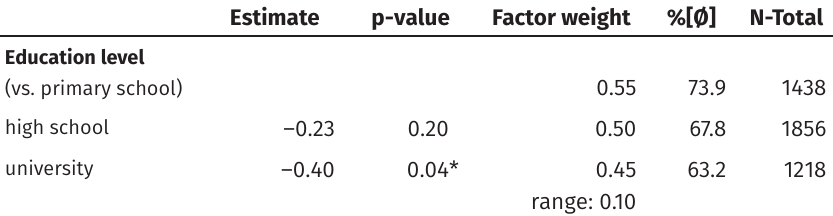
Table 11: Significant social factors for the use of null subject (intercept = 1.48; N = 4512; [Ø] =